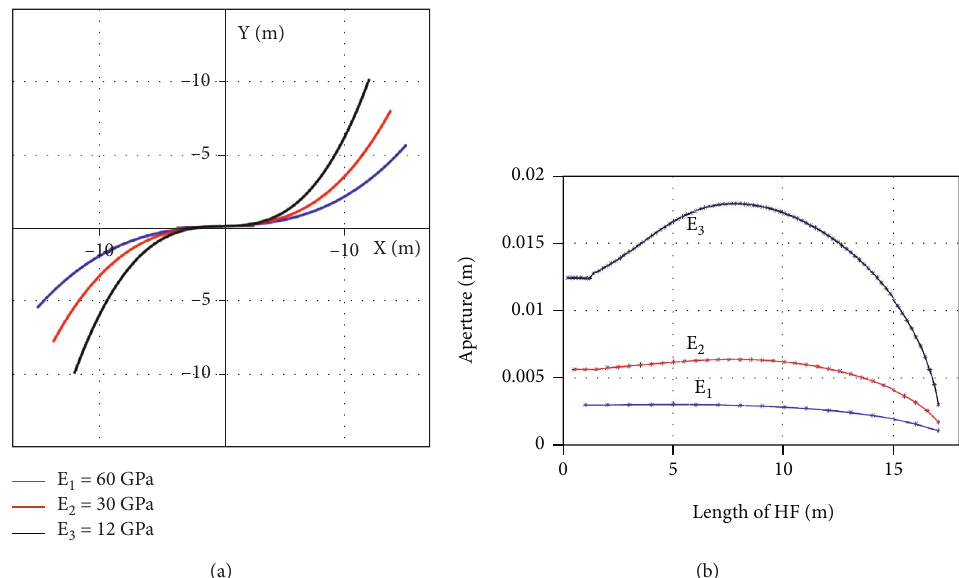
Figure 11: Simulation results with di ff erent Young ’ s moduli: (a) fracture morphology; (b) fracture aperture.